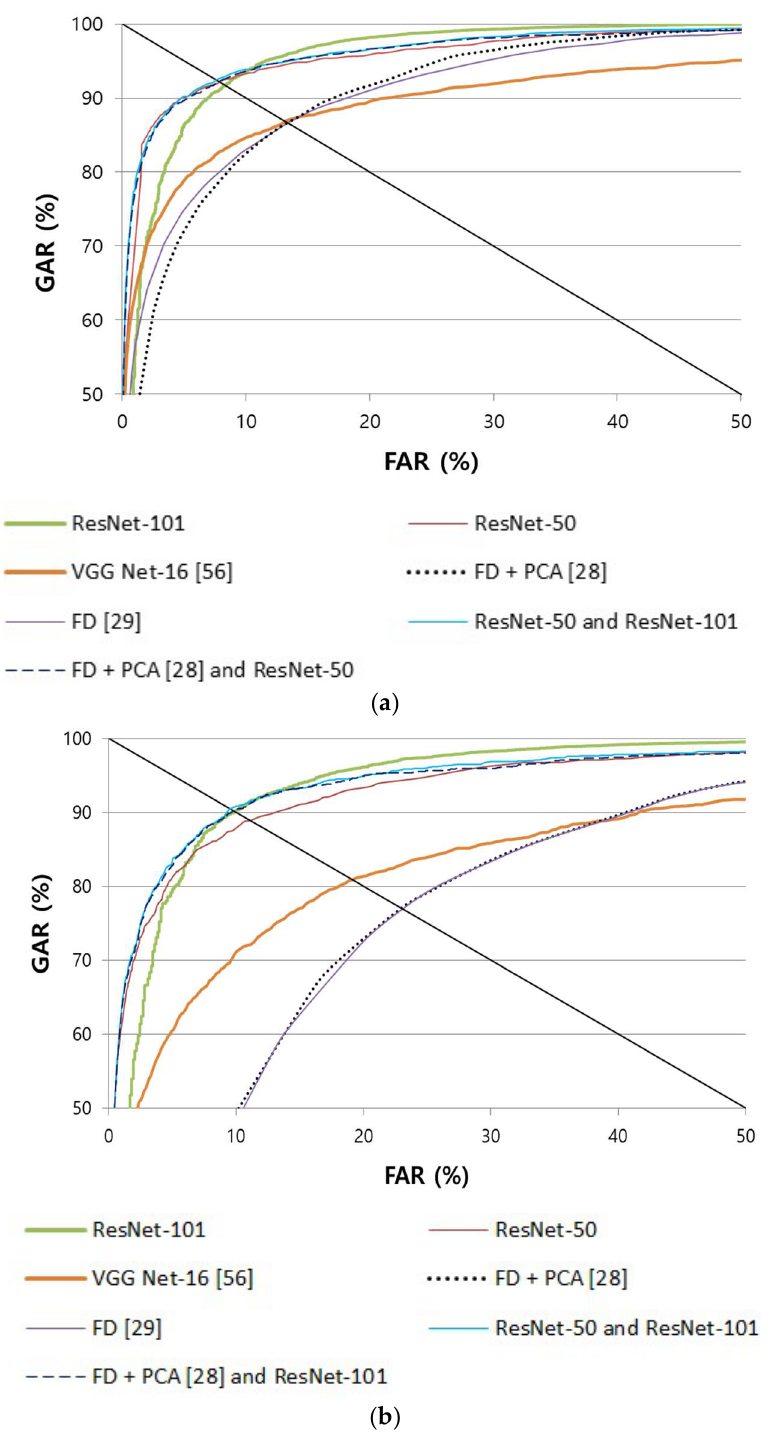
Figure 10. Comparison of ROC curves of finger shape recognition with ( a ) SDU-DB and ( b ) PolyU-DB.